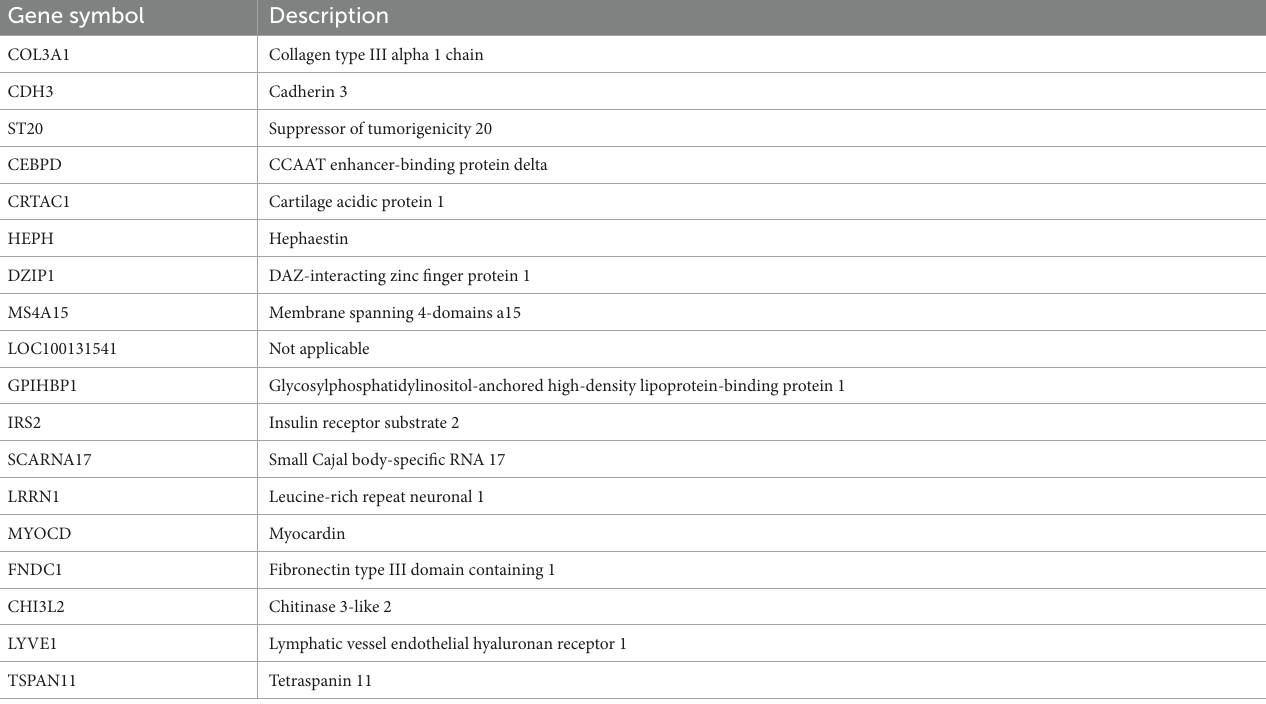
TABLE 1 Identification of 18 variables using the LASSO regression algorithm. Gene